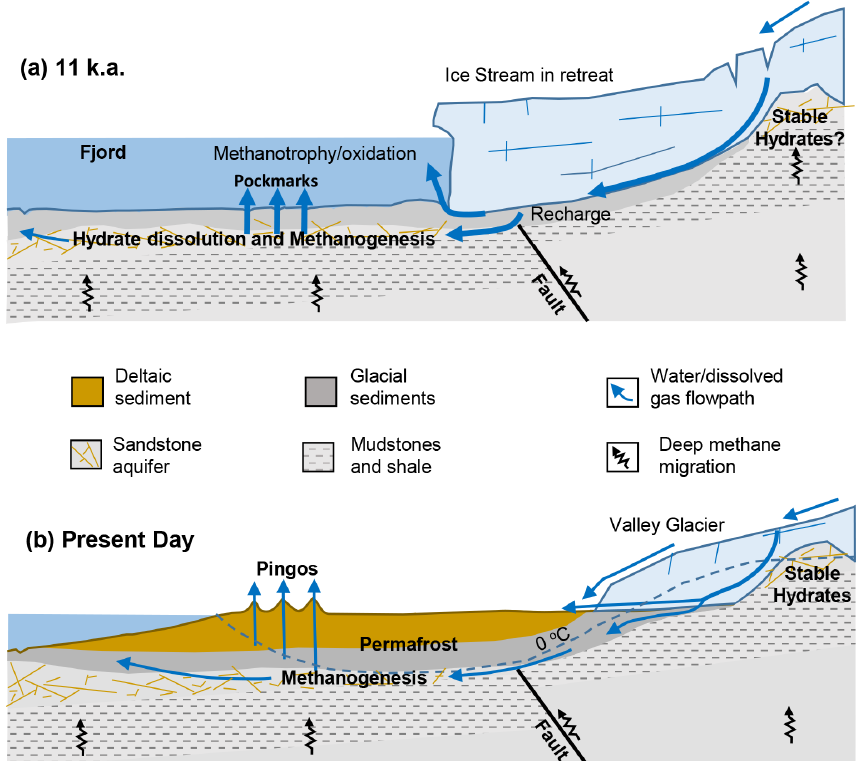
Figure 1. Landscape change and likely methane migration pathways in Adventdalen (thickness of geological units and sediments not to scale) (a) during deglaciation after the Last Glacial Maximum ca. 11000 years ago and (b) today following delta progradation, isostatic uplift and permafrost aggradation. The conceptual model of landscape change was based upon Gilbert et al.